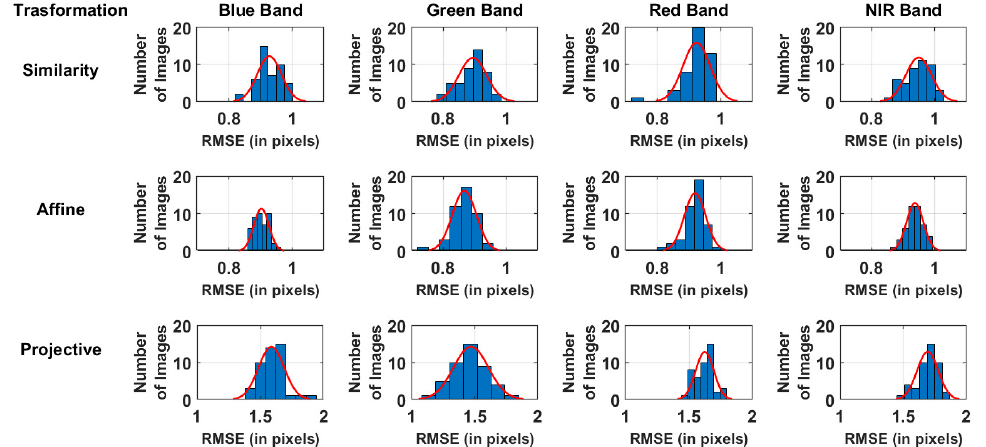
Figure 13. Distribution of the root mean square error (RMSE) computed for the inliers matching points after a forward transformation to the fixed (red-edge band) image space as a function of the transformation. The red line represents a Gaussian distribution. In order to improve visualization, the range of the x-axis was modified for the projective transformation.